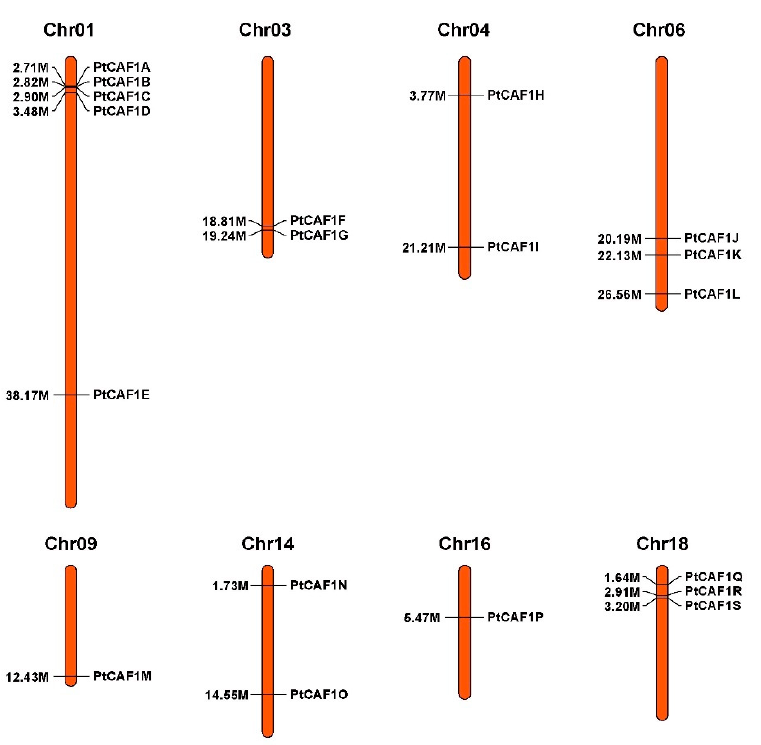
Figure 4. Chromosomal distribution of the 19 PtCAF1 genes. The scale of the chromosome is in megabases (Mb). The chromosome number is indicated at the top of each chromosome.